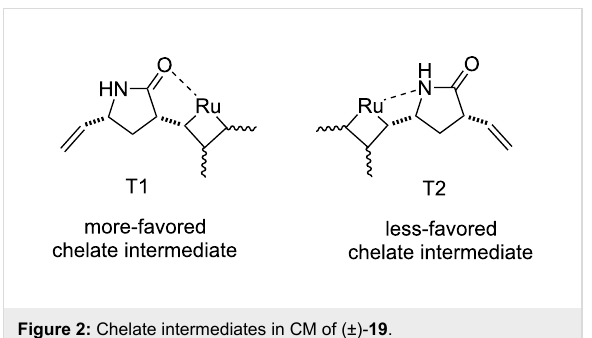
Figure 2: Chelate intermediates in CM of (±)- 19